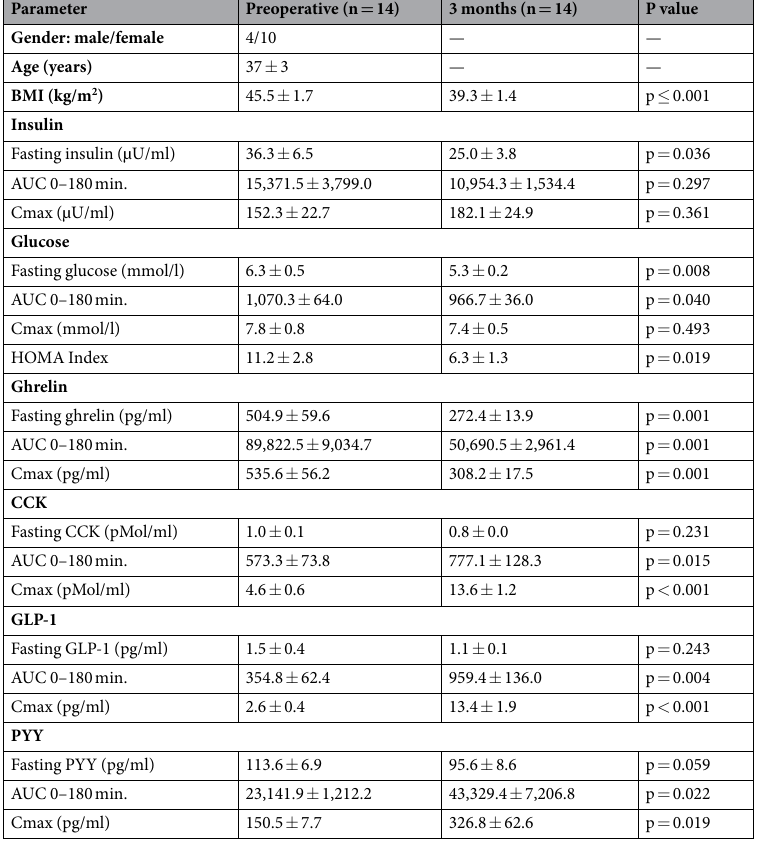
(Table 1 and Figure S1). Our investigations indicated that age did not affect the hormone responses. Determination of tissue expression of gut hormones in the stomach and duodenum of mor- bidly obese subjects (Group 2). Twenty seven non-diabetic morbidly obese subjects, who consented to provide stomach and duodenal biopsies pre- and post- LSG, were used in this study. There were 6 drop-outs (5 patients did not want to come back after surgery, one patient had an incidental finding of antrum carcinoma and had to be excluded). Of the morbidly obese patients, 21.1% (7/33) were positive for Helicobacter pylori preoperatively. After surgery there was a marked reduction in BMI from 47.2 ± 1.7 kg/m 2 (range: 35.6–75.7) to 39.3 ± 1.4 kg/m 2 (range: 27.1–53.2). The control group consisted of 24 healthy lean subjects (Table 2). Assessment of chromogranin A- and ghrelin-containing EECs in the stomach. Using immunohistochemistry, we showed that there was a 2.2- (p < 0.001) and 2.7-fold (p < 0.001) decline in the total number of chromogranin A (ChA)-containing EECs in the lesser and greater curvature of the stomach, respectively, in obese compared to lean individuals. In the same obese individuals post-operatively there was a 1.6-fold (p < 0.05) increase in the number of these cells in the lesser curvature compared to pre-LSG (Figure S2 and Table S1). Tissues from the greater curvature were no longer available after surgery to be compared. Using an average cell count of 500, we observed a 2.5- (p < 0.001) and 2.8-fold (p < 0.001) decrease in EECs containing ghrelin in the lesser and greater curvature respectively, in the obese stomach compared to lean. The number of ghrelin-containing cells was increased 1.5-fold (p < 0.05) in lower curvature of post-operative vs. pre-operative obese subjects, however this was still 1.5-fold (p < 0.05) lower than lean controls. We showed that the greater and lesser curvature of the